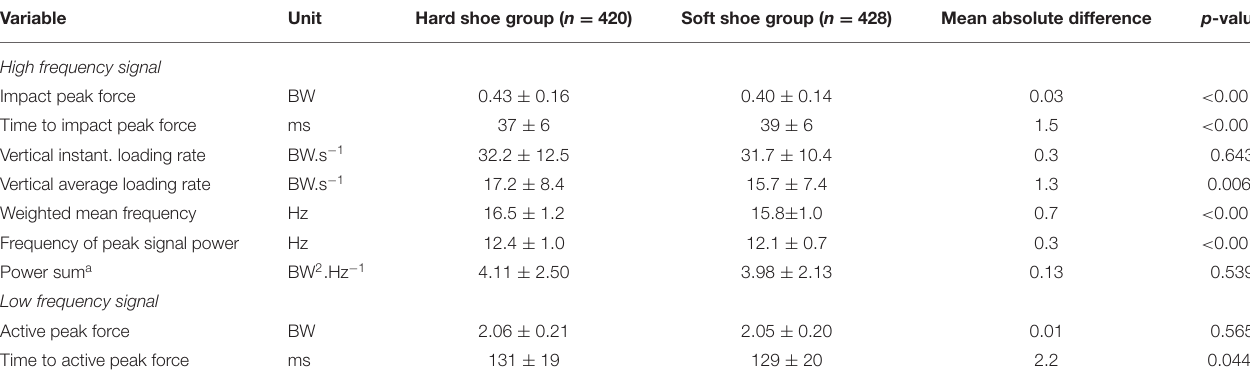
TABLE 2 | Effect of shoe version on force characteristics of the high and low frequency signals ( n = 848).